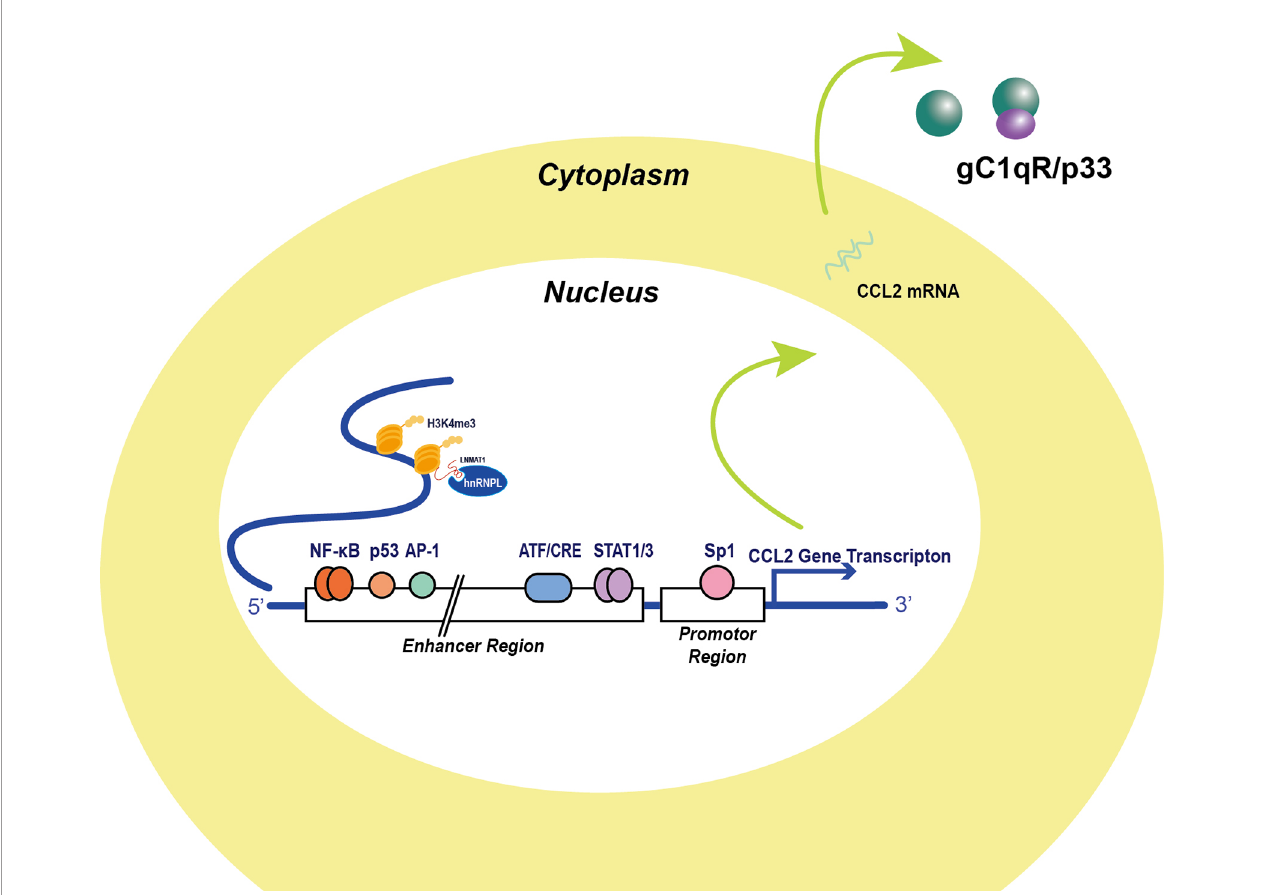
FIGURE 1 | Transcription factors and post-translational factors in the regulation of CCL2 expression. Several transcription factors binding to CCL2 regulating sequences were identi fi ed in the 5 ’ UTR. The classical NF- k B signaling molecule RelA binding site locates approximately from position -2650 to position -2600 and Sp-1 binds to the promoter of the CCL2 gene, which are major activators of CCL2 expression. AP-1 was thought to be another major promotor of CCL2 transcription, but AP-1 binding activity appears irrelevant to CCL2 transcription activity. Additionally, p53 molecule binding to the enhancer sequence in cooperation with NF- k B signaling activation and stabilize NF- k B signaling. Apart from this, signal transducer and activator of transcription 1 and 3 dimers, which are also signi fi cant in fl ammatory signal molecules, transcriptionally prompt CCL2 expression. Moreover, Stress stimuli-induced factor ATF3 also binds to three ATF/CRE sites in the enhancer region and attenuates CCL2 transcription (2). Non-coding RNA like LNMAT1 recruits hnRNPL for H3K4me3 and enhances the CCL2 transcription